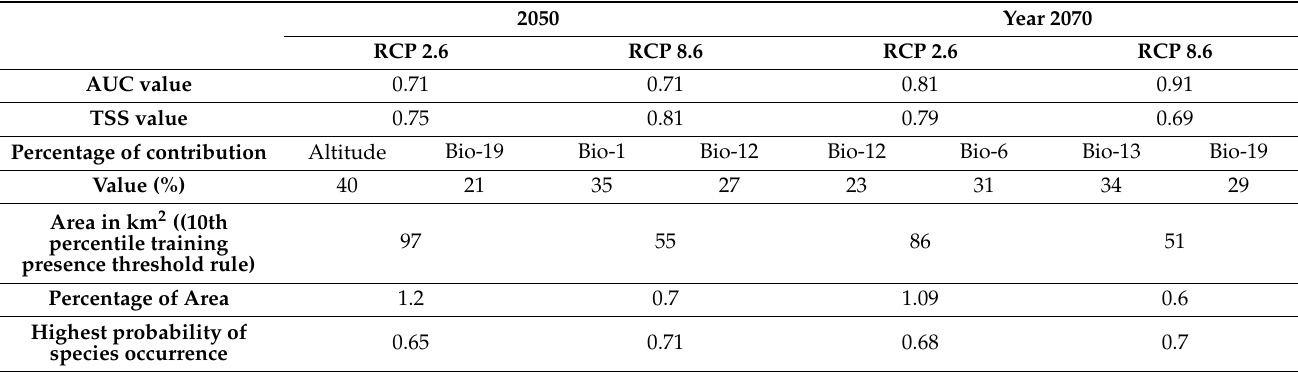
Table 2. Prediction accuracy of C. himalaicum species under future climatic scenarios.